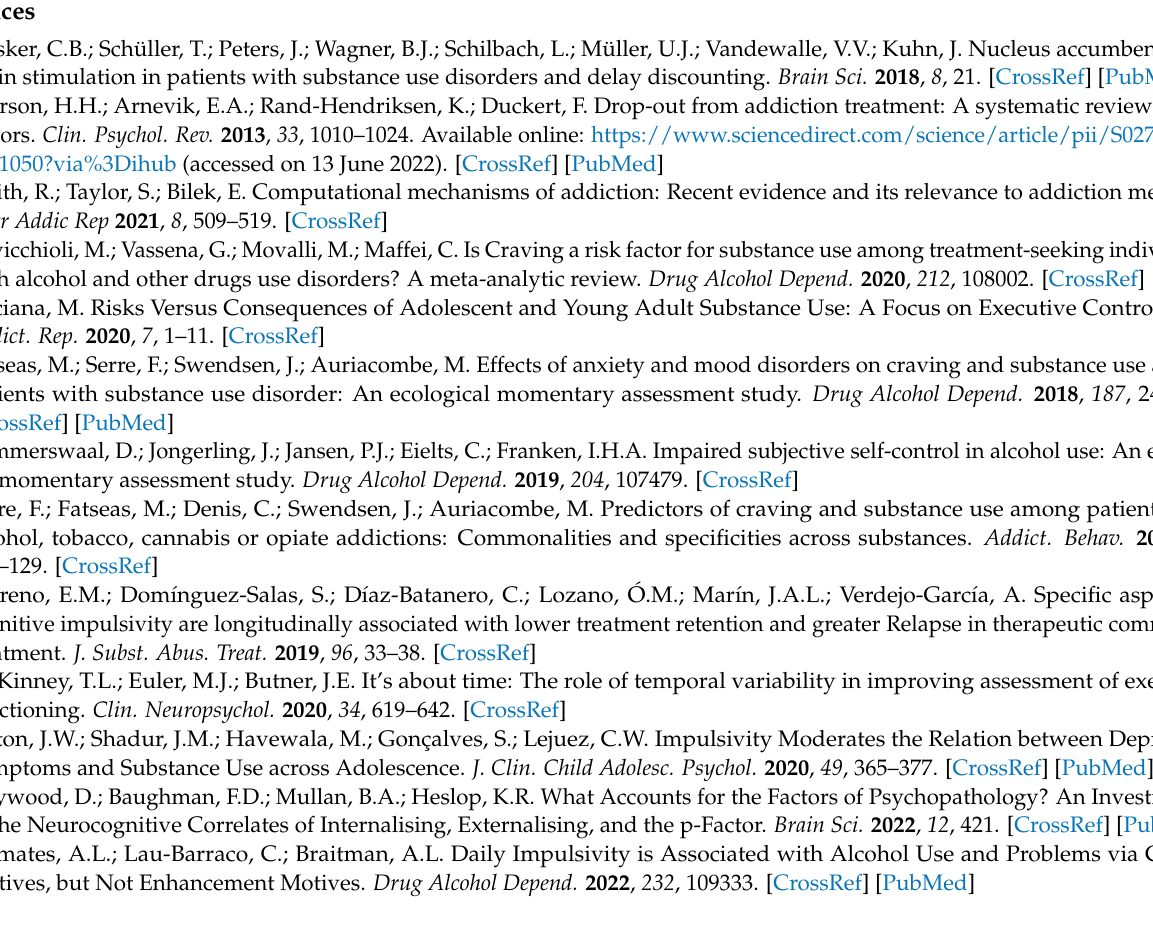
Figure A4. Rolling 3 session Sd of Self-control per session (time). Figure A3. Rolling 3 session Sd of Self-control per session